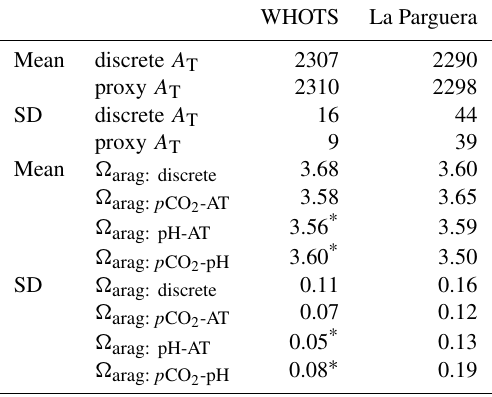
Table 2. Mean and variability, as measured by 1SD, for A T and (cid:127) arag data sets at the WHOTS and La Parguera mooring sites. Dis- crete measurements for WHOTS are from the Hawaii Ocean Time- series program (http://hahana.soest.hawaii.edu/hot/) and for La Par- guera are from the Atlantic Ocean Acidification Test-Bed project. Proxy A T measurements are estimated from moored SST and SSS